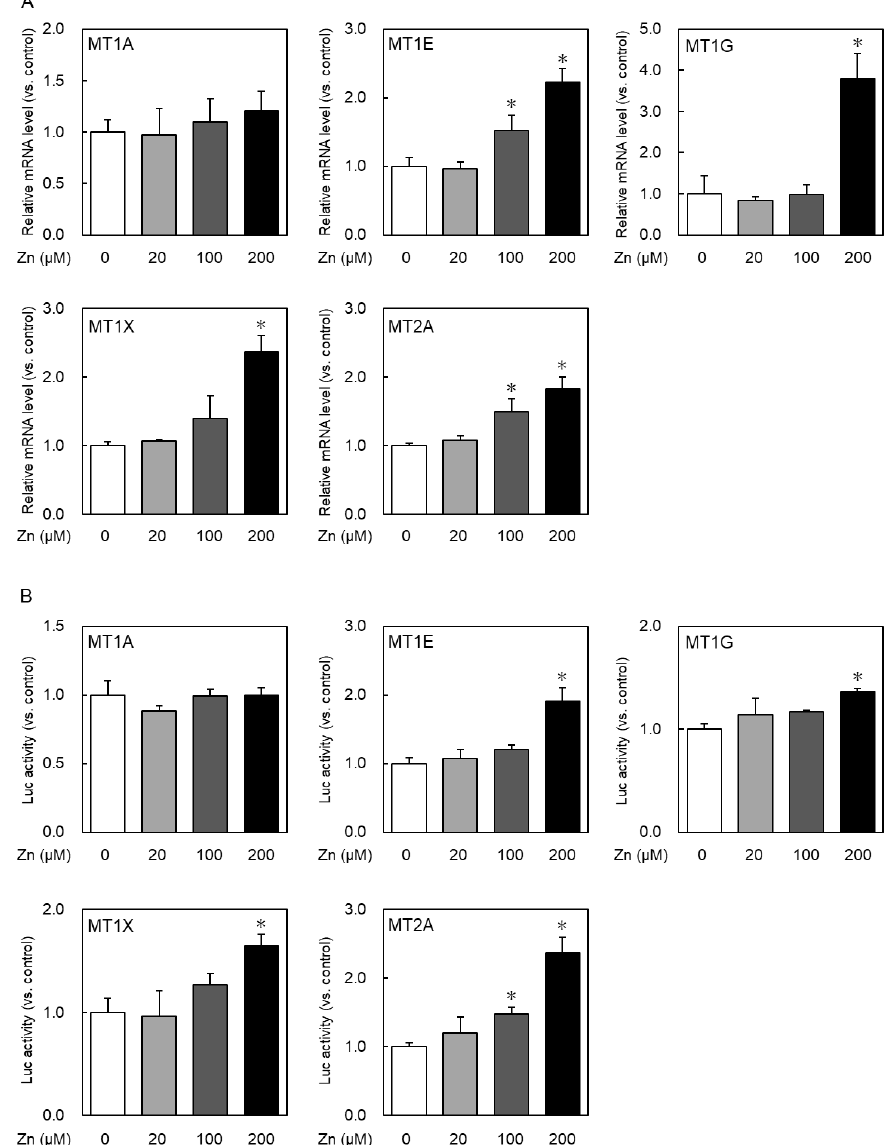
Figure 2. Each MT isoform expression after zinc treatment. ( A ) HeLa cells were treated with zinc at the indicated concentrations for 6 h, and the MTs mRNA expression was determined via real-time RT-PCR. ( B ) HeLa cells were co-transfected with luciferase reporter vector, pRL-SV40 vector for internal control, and pEGFP. At 24 h after transfection, the cells were treated with zinc at the indicated concentrations for 6 h, and luciferase activity was measured using the dual-luciferase assay system. pGL4.12-MT1A – 1858/+23, pGL4.12-MT1E – 1925/+43, pGL4.12-MT1G – 636/+59, pGL4.12-MT1X – 1879/+71, and pGL4.12-MT2A – 1672/+55 were used as luciferase reporter vectors. * p < 0.05 indicates significant difference from the untreated group.